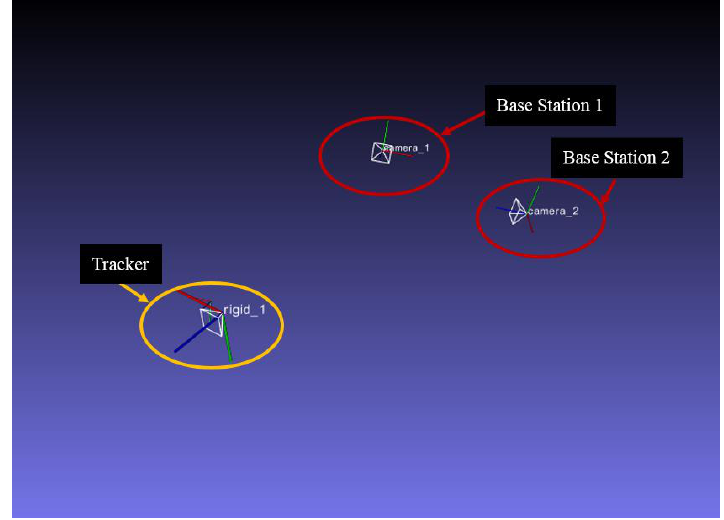
Figure 5. Motion of the tracked object updates the 3D representation in real time.